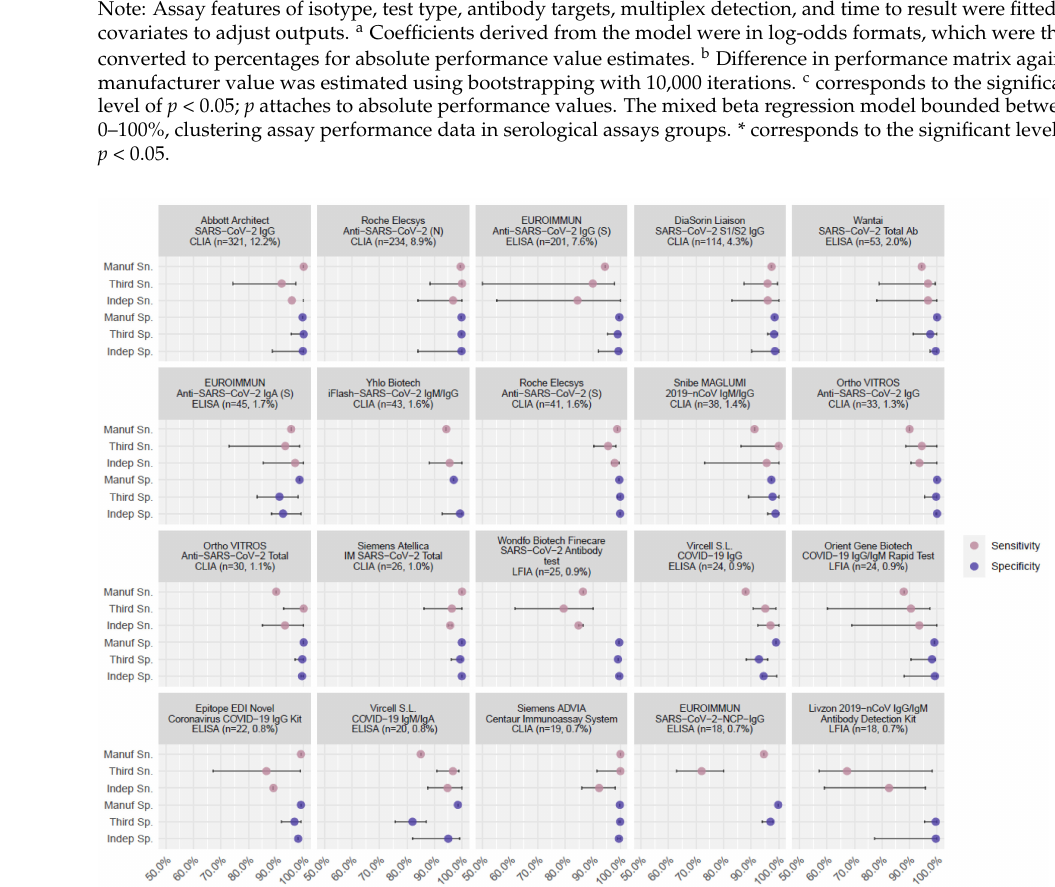
Figure 1. The difference in reported assay performance among manufacturer evaluation, third party evaluation, and independent evaluation. Note: the figure shows the side-by-side comparison of assay performance for the top 20 assays. Performance evaluations came from three sources: manufacturer reports, third-party labs, and independent groups. Intervals show the range of performance values for a certain assay derived from the given evaluation